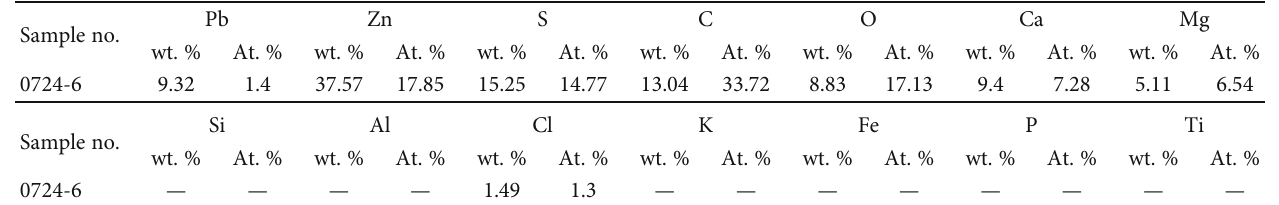
Table 3: EPMA test results.